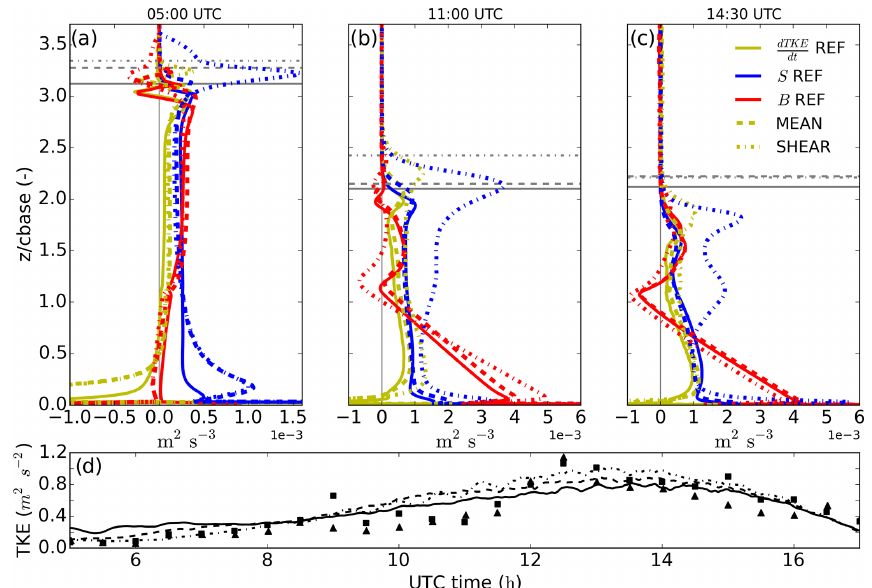
Figure 8. Slab-averaged vertical profiles of 20min averaged turbulent kinetic energy tendency (yellow line), shear contribution (blue line) and buoyancy contribution (red line) for REF (solid line), MEAN (dashed line) and SHEAR (dotted–dashed line) at 05:00 (a) , 11:00 (b) and 14:30UTC (c) . The height is normalized by cloud base height at the vertical axis. Following the same line coding, grey horizontal lines indicate the cloud top for each time and experiment. In (d) and following the same line coding are the time series of the simulated turbulent kinetic energy at 10m high and, indicated by triangles and squares, as observed by two independent stations at the Savè supersite on 26 June